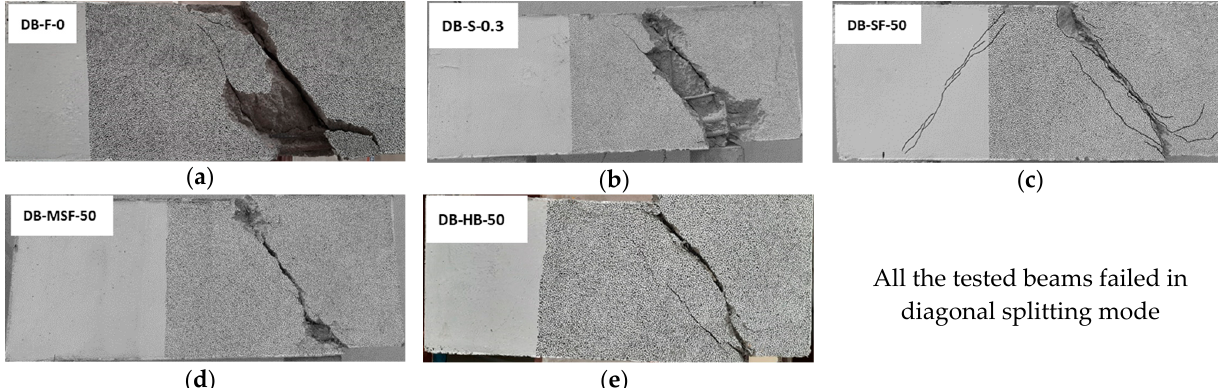
Figure 14. Final failure modes of deep beams: ( a ) DB-F-0, ( b ) DB-S-0.3, ( c ) DB-SF-50, ( d ) DB-MSF-50, ( e ) DB-HB-50.